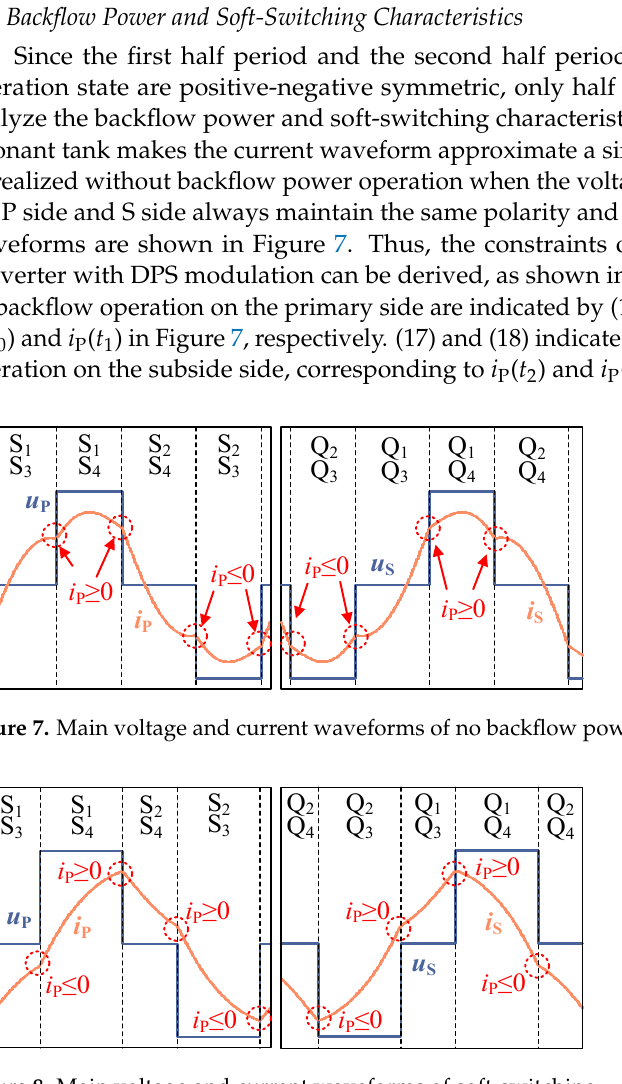
Figure 6. The relationship between phase shift ratio and THD i S with DPS modulation.